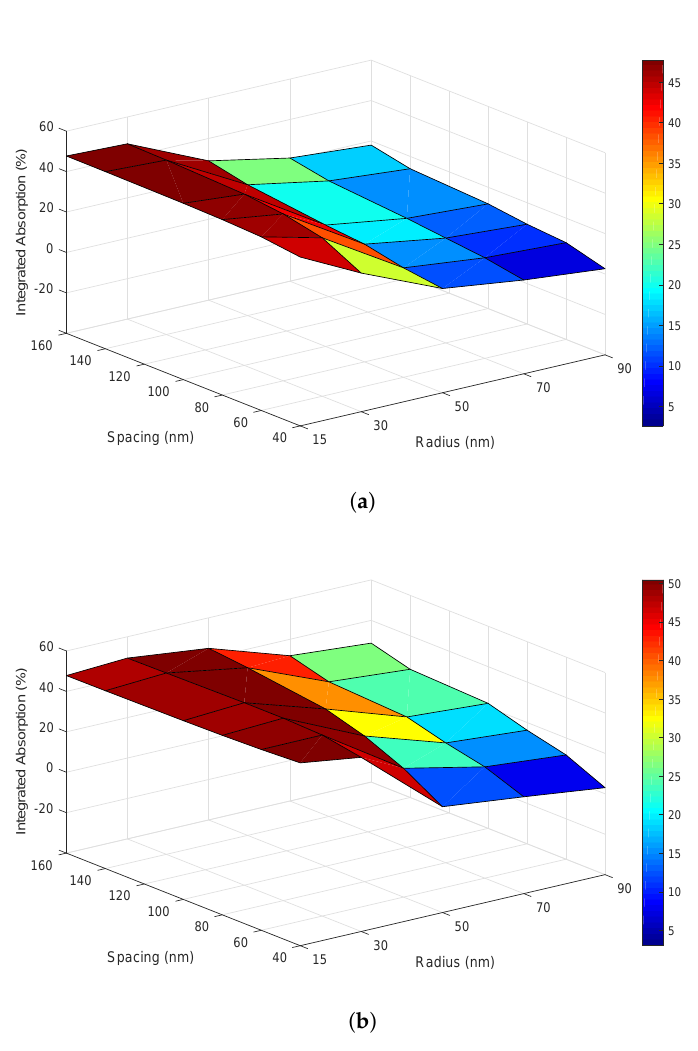
Figure 4. Integrated absorption factor G (%) in silicon as a function of radius and inter particle spacing of ( a ) Ag Nanoparticle ( b ) Al